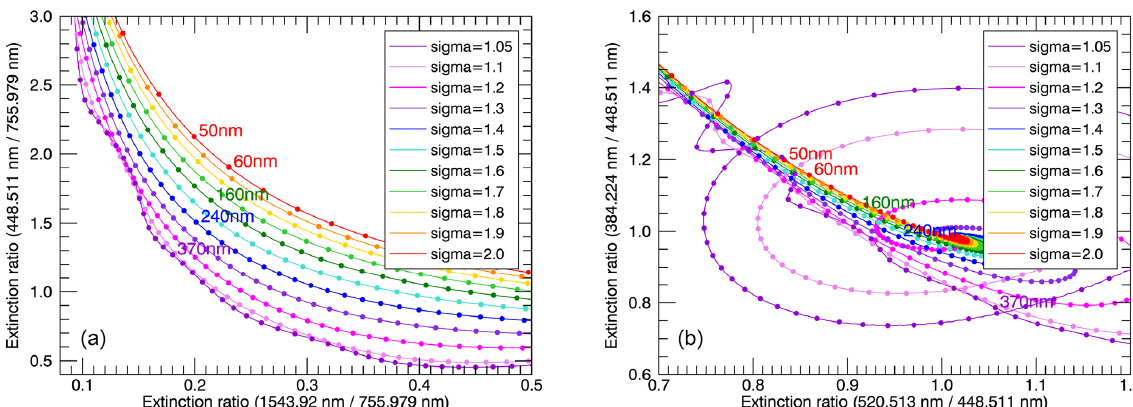
Figure 2. Extinction ratios at three wavelengths as a result of Mie calculations for values of median radii between 1 and 1000nm and mode widths between 1.05 and 2.0. The dots mark r med values with increments of 10nm. The respective r med values of five selected dots are shown in the colour corresponding to their mode width. Panel (a) shows the set of curves to be compared to SAGE III/ISS measurements for the PSD parameter retrieval. Panel (b) shows an unusable set of curves with broad areas of non-unique solutions for the PSD parameters due to the closeness of the wavelengths